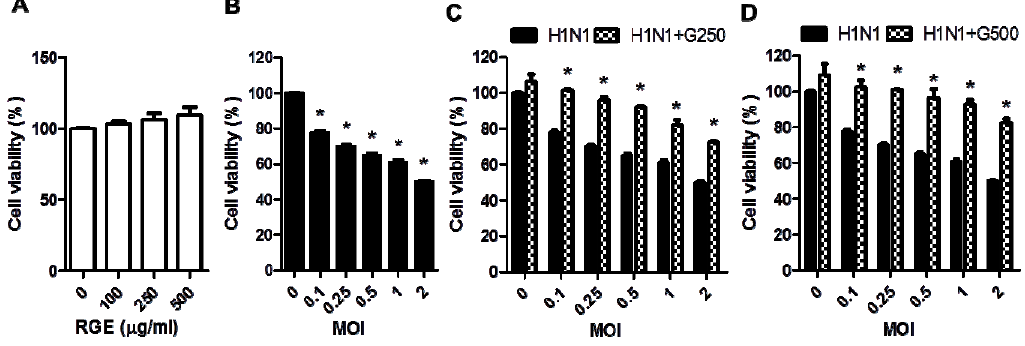
Figure 1. Influence of red ginseng extract (RGE) on H1N1 influenza A virus-induced cytopathogenic effect (CPE) formation in A549 cells. ( A ) Influence of different RGE concentrations on the growth of A549 cells. Values are the mean ± SEM. * p < 0.05 vs . mock control; ( B ) Influence of different H1N1 influenza A virus MOIs on the growth of A549 cells. Values are the mean ± SEM. * p < 0.05 vs . mock control; ( C , D ) Influence of different RGE concentrations on the growth of A549 cells infected with H1N1 influenza A virus at different MOIs 48 h post infection. A549 cells were continuously treated with RGE starting with 24 h pre-incubation period. Cell viability was measured by MTT assay.